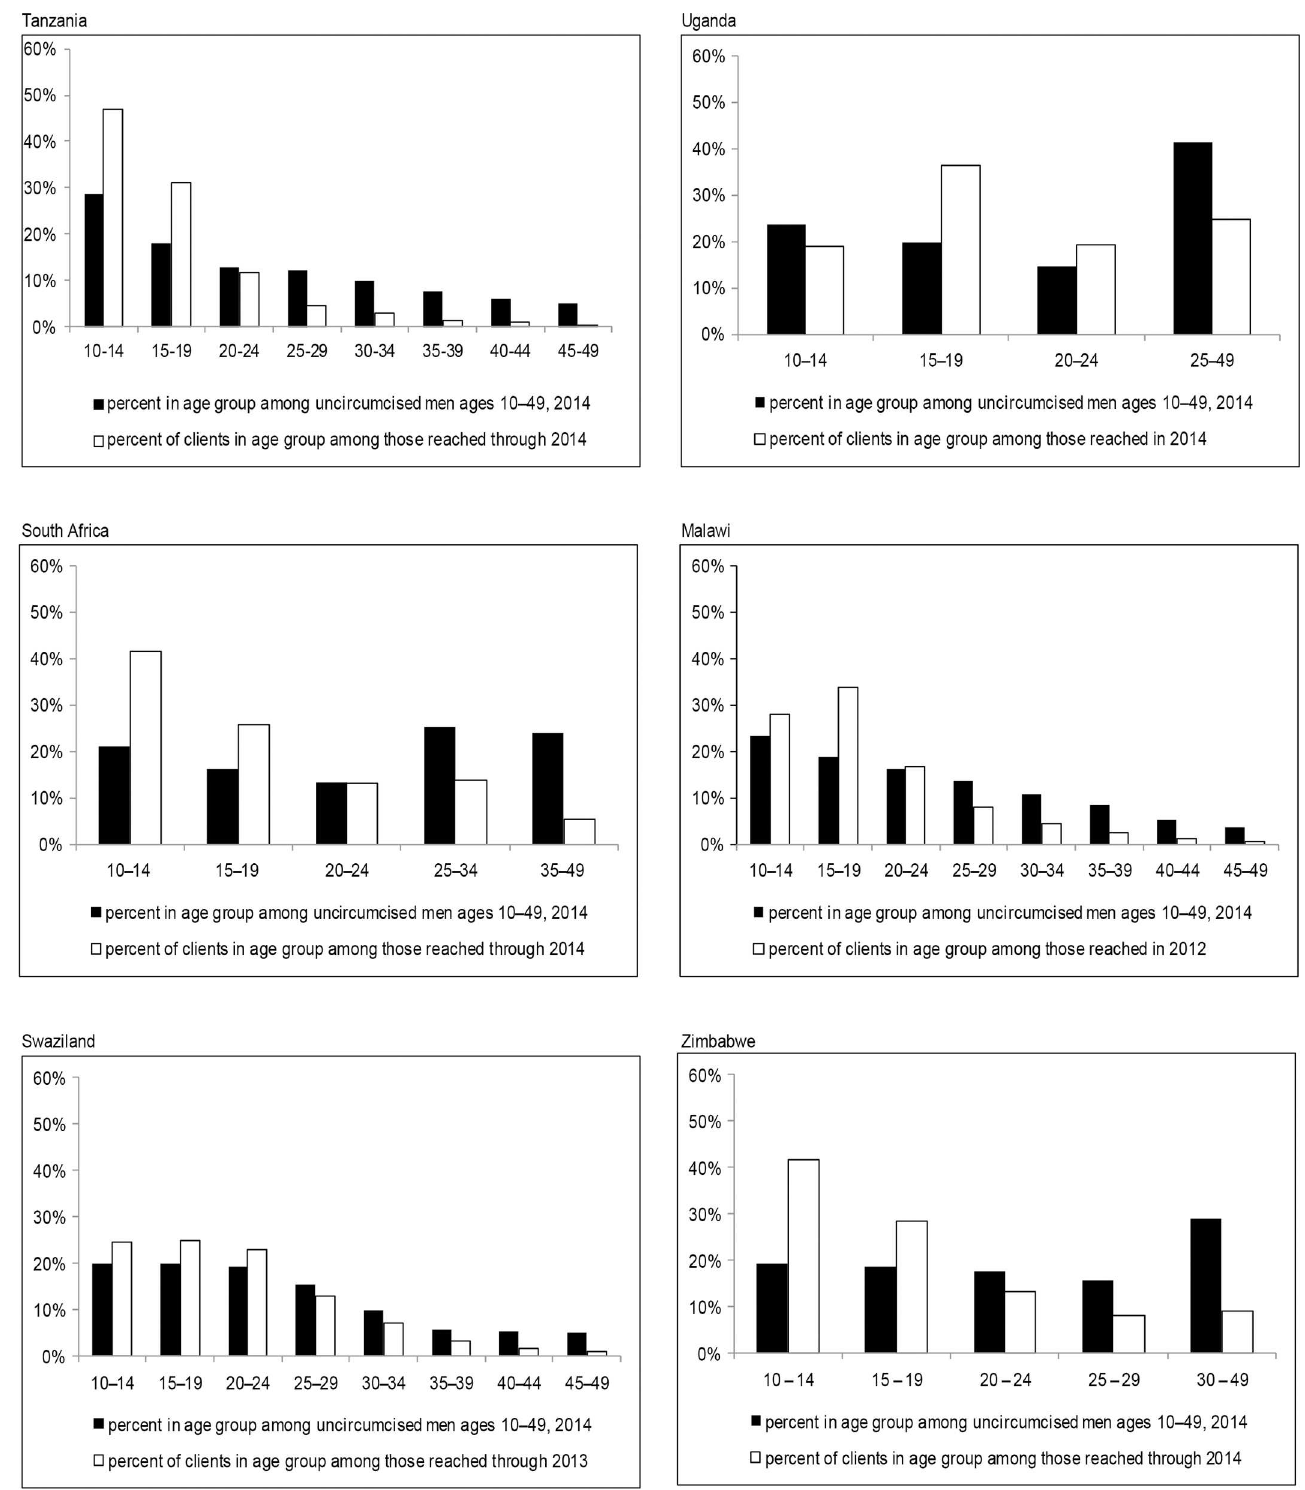
Fig 1. Comparison of VMMC client age groups to their representation in the general male population that is uncircumcised.